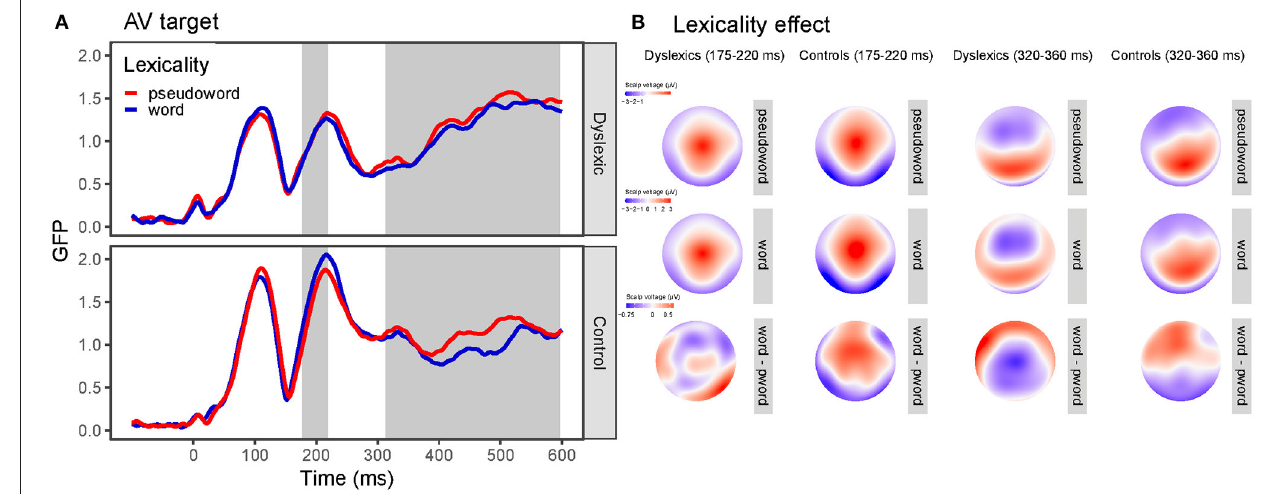
FIGURE 6 | Global field power (GFP) curves and topographic maps for the visual and audiovisual target stimuli. (A) GFP for the word and pseudoword targets separately for the dyslexia and control group. Gray areas highlight the time windows in which the effect was significant according to the GFP (first area) and the GMD (second area) analysis. (B) Topographic maps for the word and pseudoword targets and their difference (lexicality effect) separately for the dyslexia and control group for the time window where GFP (175–220ms) and GMD (320–360ms) differed between the groups.